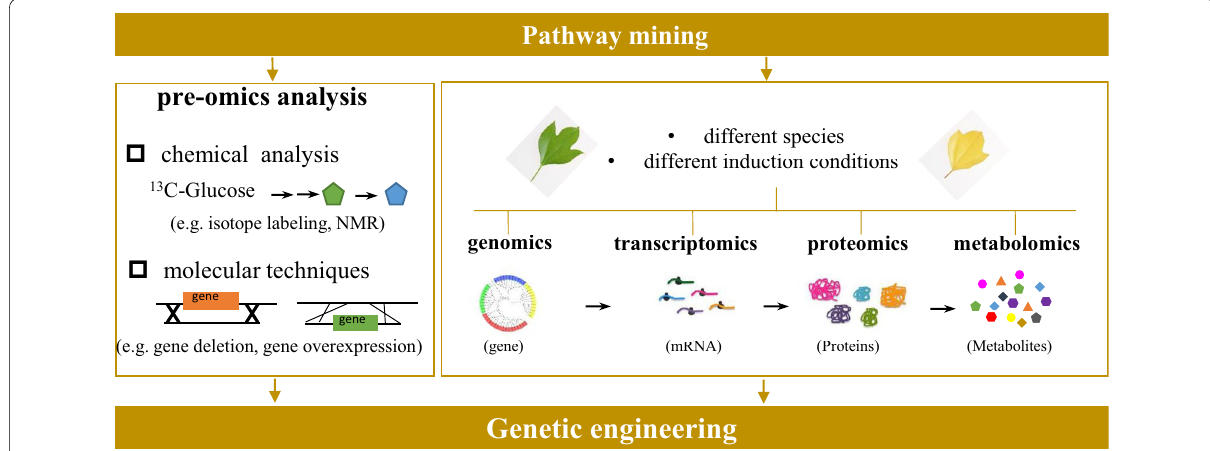
Fig. 2 Overview of strategies for exploration of metabolic pathways in nature producers. Pre-omics analysis methods consist of chemical analysis (e.g., isotope labeling, NMR analysis) and molecular techniques (e.g., gene deletion, gene expression, DNA sequencing by genome walking); omics technologies include genomics, transcriptomics, proteomics and metabolomics. Both of them offer powerful tools to discover new genes, gene clusters, transcription factors as well as pathways for synthesis of bioactive